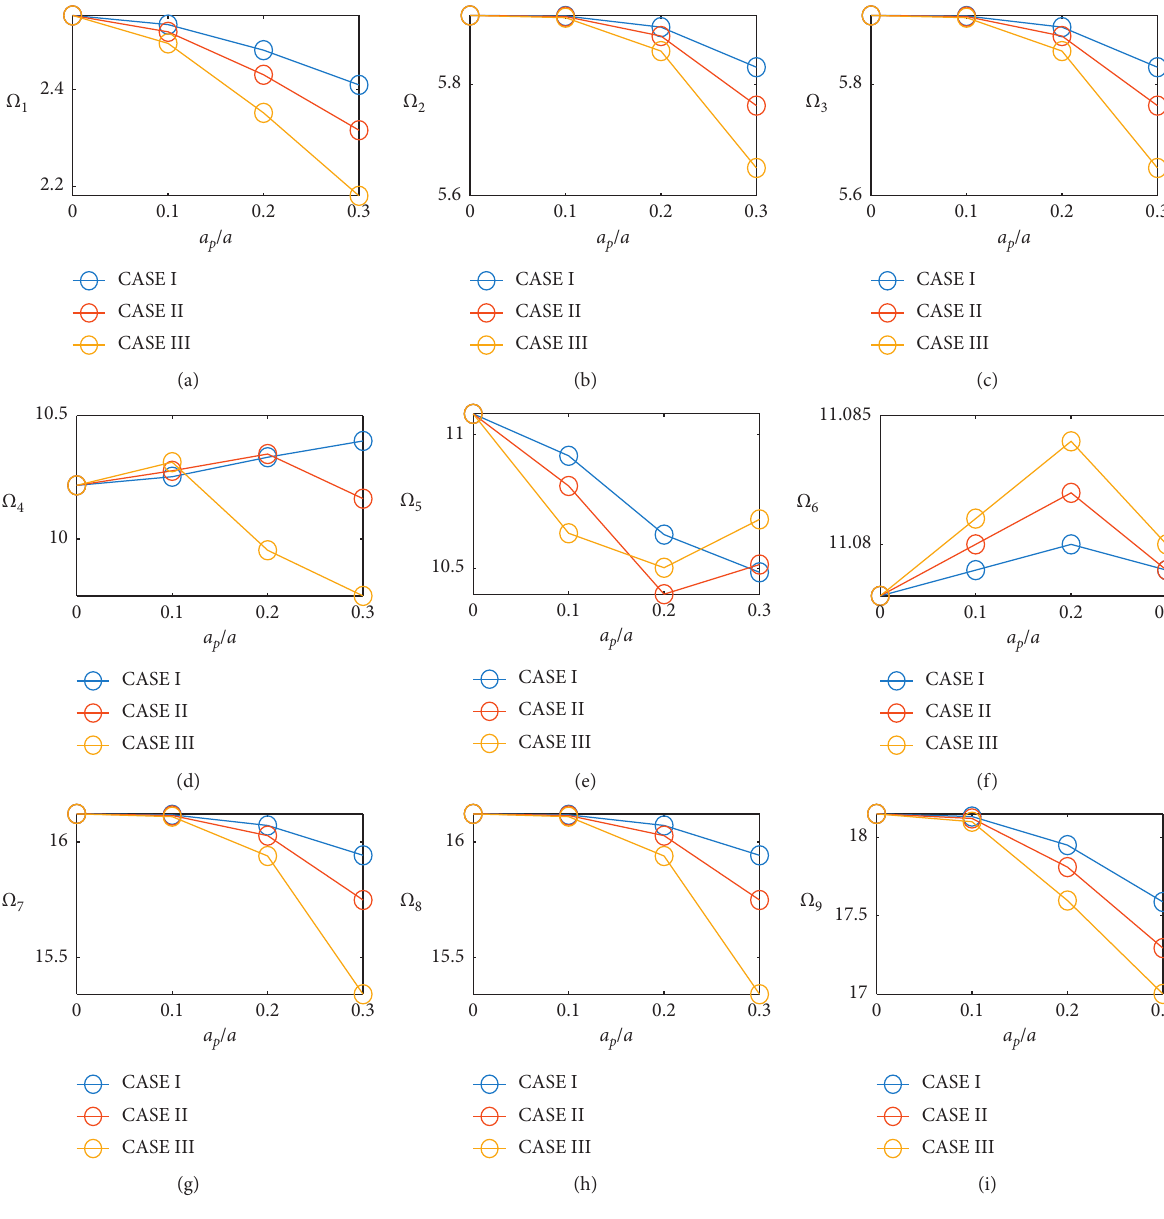
Figure 7: Nondimensional frequencies of the angle-ply laminate ([45/ − 45]s) with SSSS boundary condition, E 1/ E 2 � 10, and a � b � 10h and for different patch sizes and